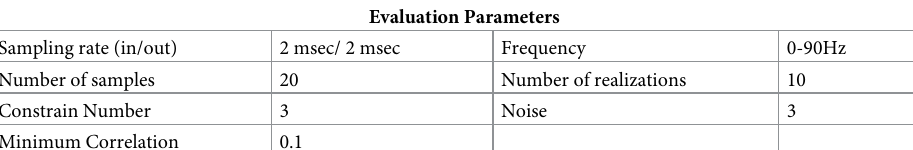
Table 2. Parameters for the experiment.